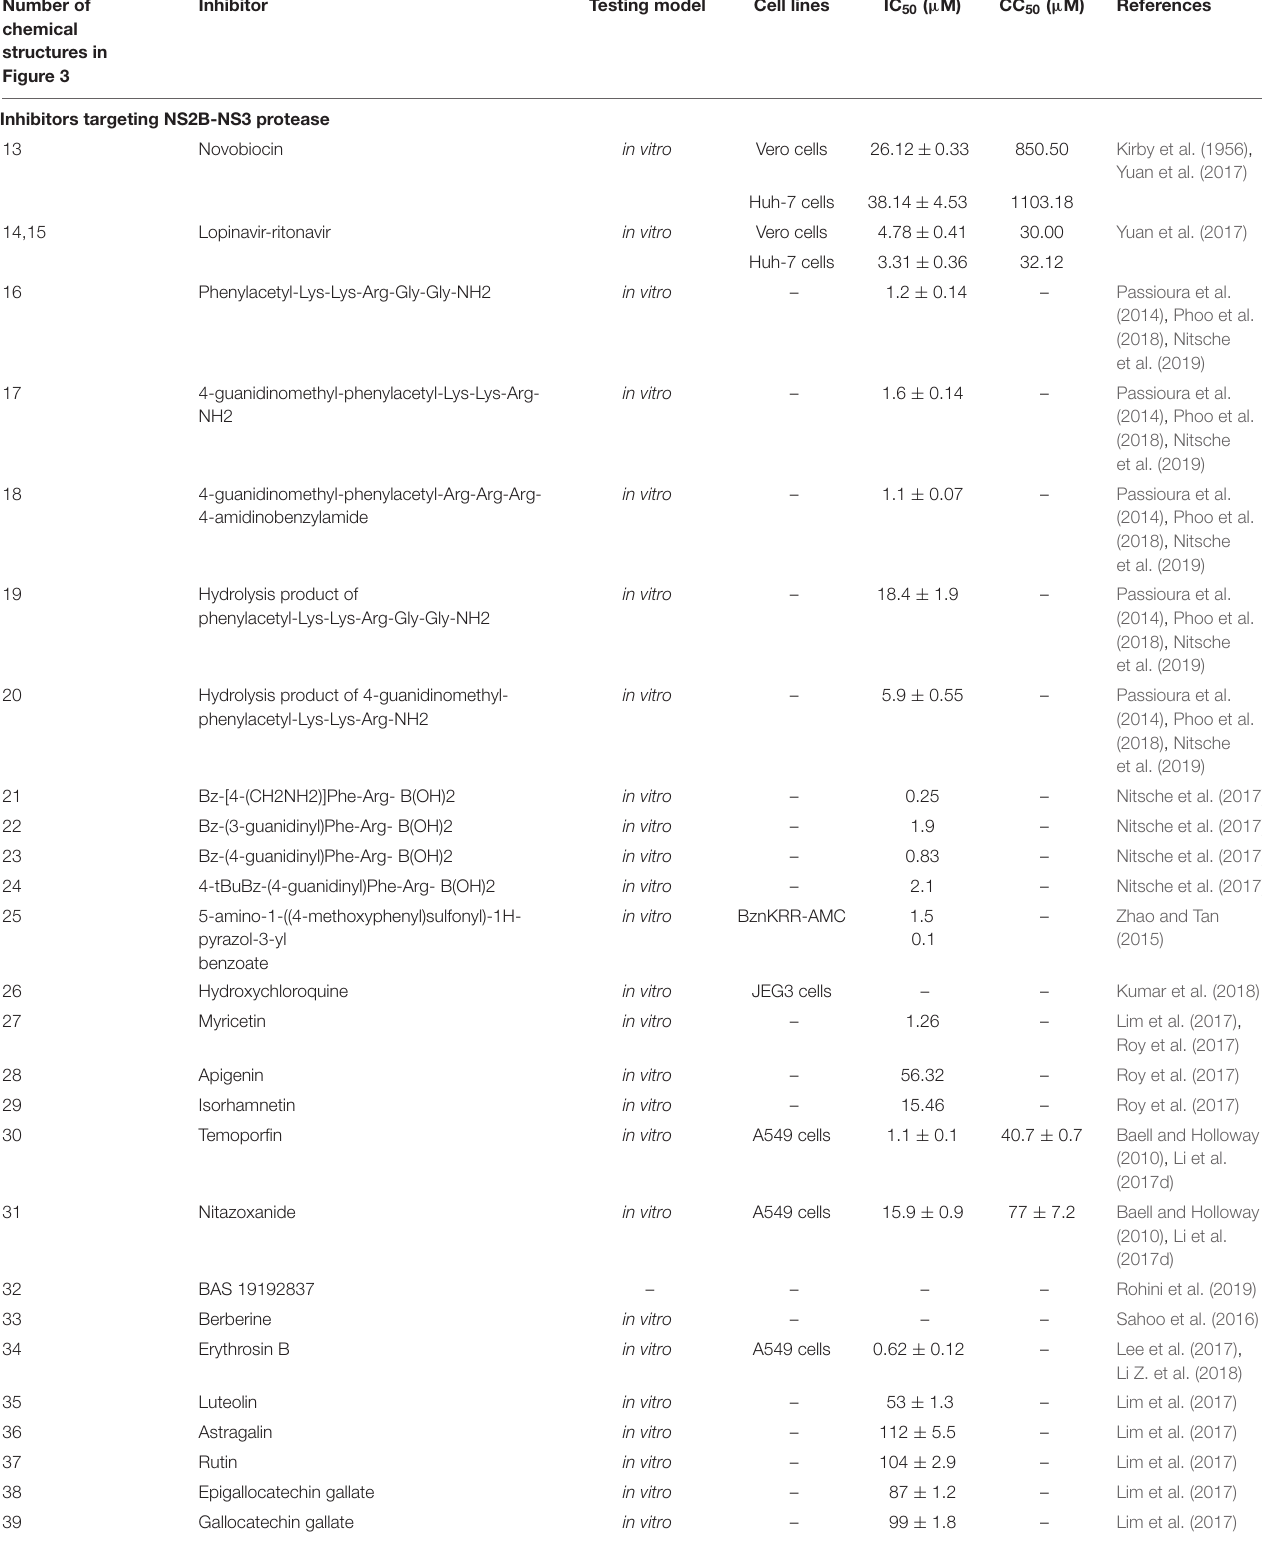
TABLE 3 | Zika virus replication inhibitors. Number of